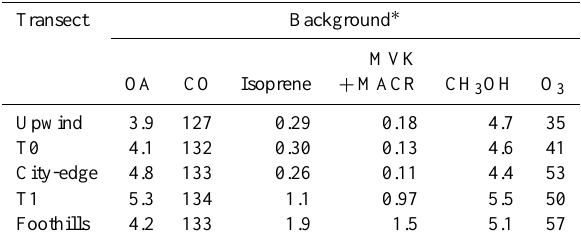
Table 3. Backgrounds averaged over transects at five locations. Transect